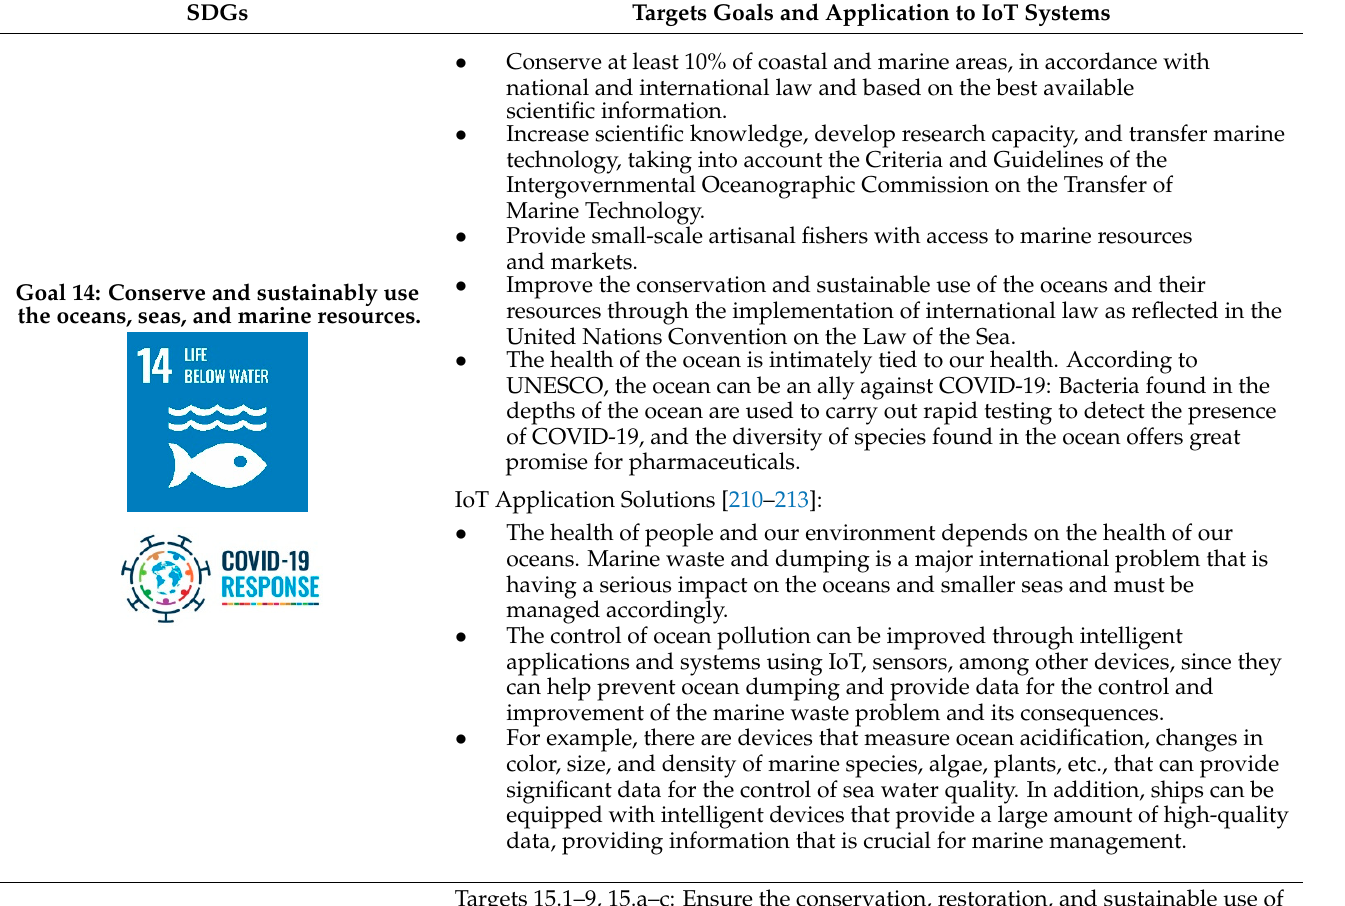
Goal 1: End poverty in all its forms